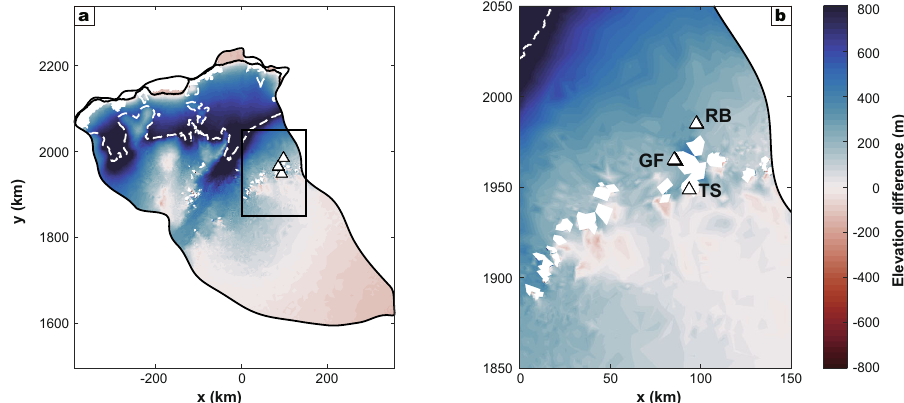
Fig. 5 Surface elevation difference between the best- fi t LGM experiment and the contemporary ice surface. Positive values denote thicker ice during the LGM, while ice-free areas are in white (see Supplementary Note 2 for more details). a Dashed white line marks the modern grounding-line. Rectangle outlines the location shown in b . Study sites (Fig. 1c) are shown as white triangles. b Terningskarvet (TS) Grjotfjellet (GF), and Rabben